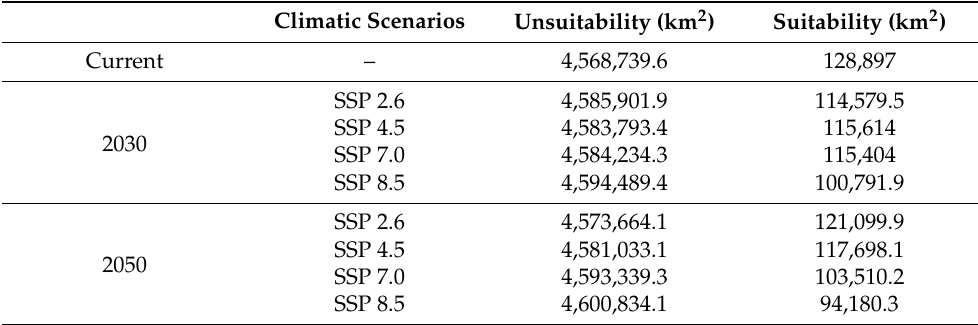
Table 9. Predicted suitable areas under the current and future climatic conditions during January– May (India).